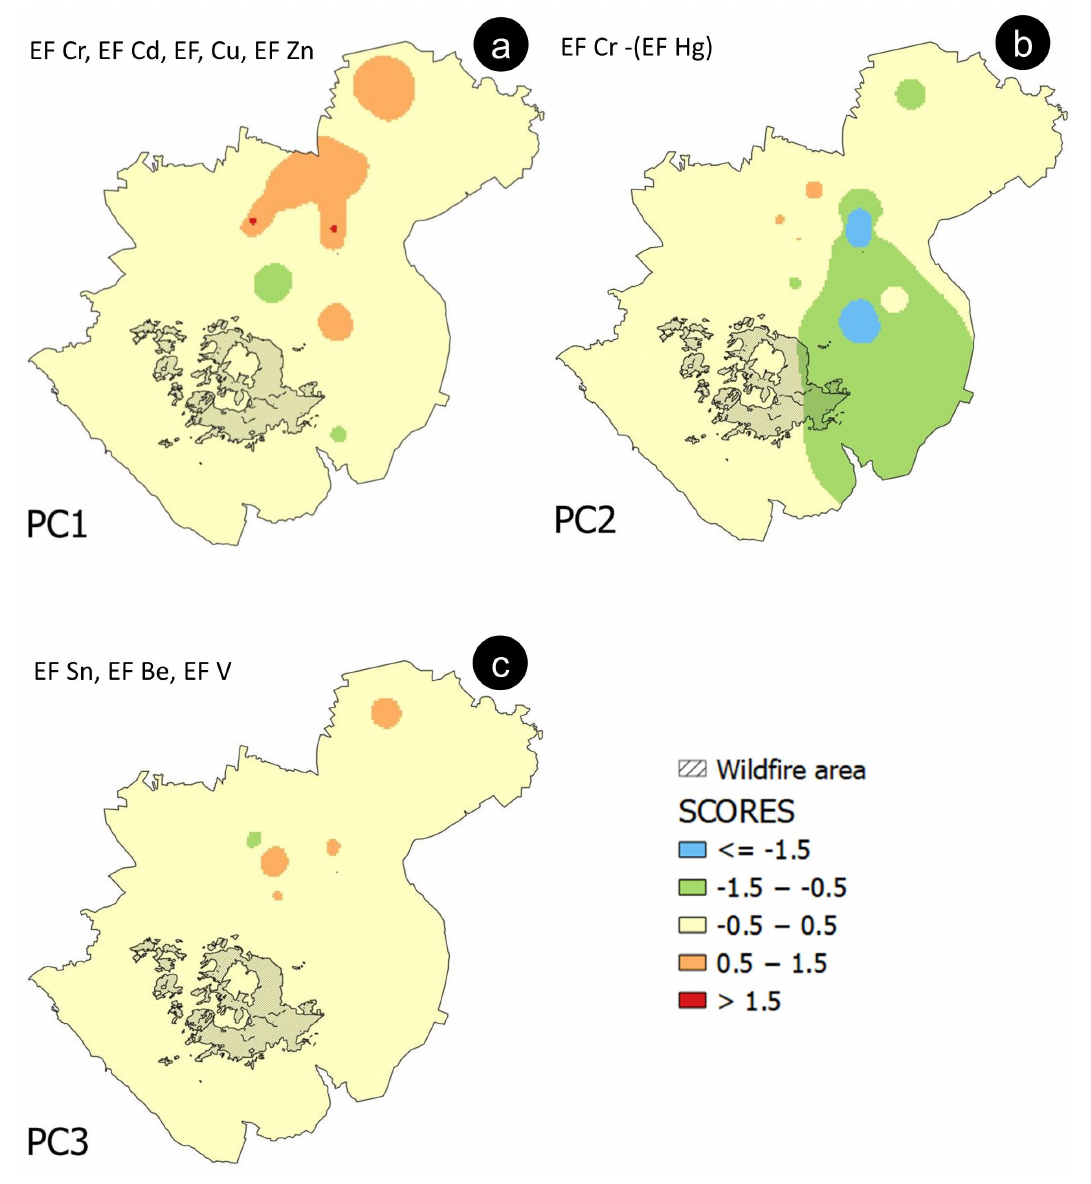
Figure 9. Figure 9. Interpolated maps of scores assigned to observations (samples) related to ( a ) PC1, ( b ) PC2, and ( c )